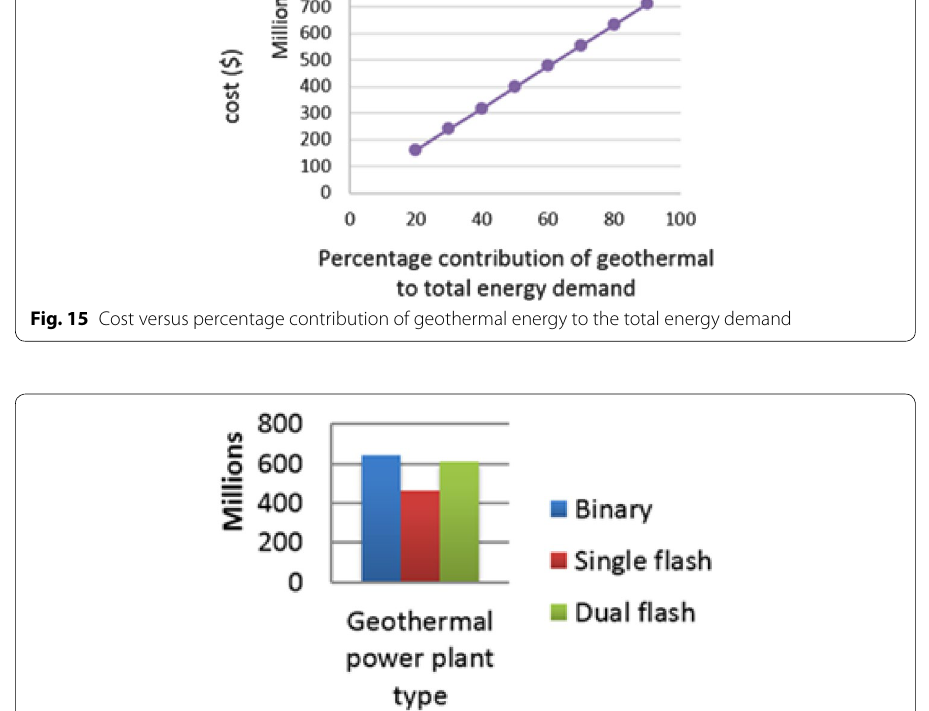
Fig. 16 Annual energy production in kWh at 80% contribution for three different power plants